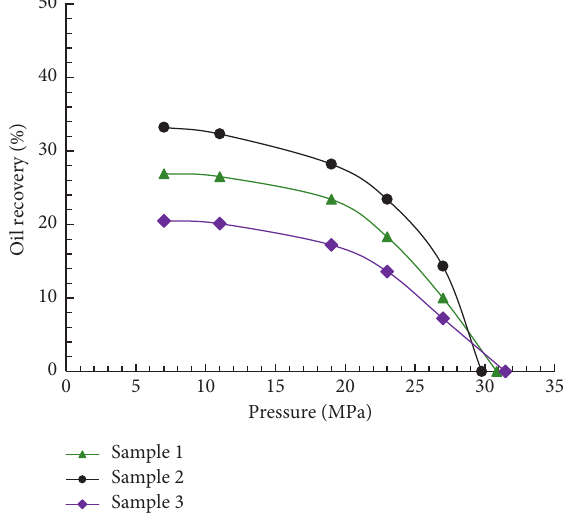
Figure 5: The relationship diagram between the condensate oil recovery and pressure of condensate with different CO 2